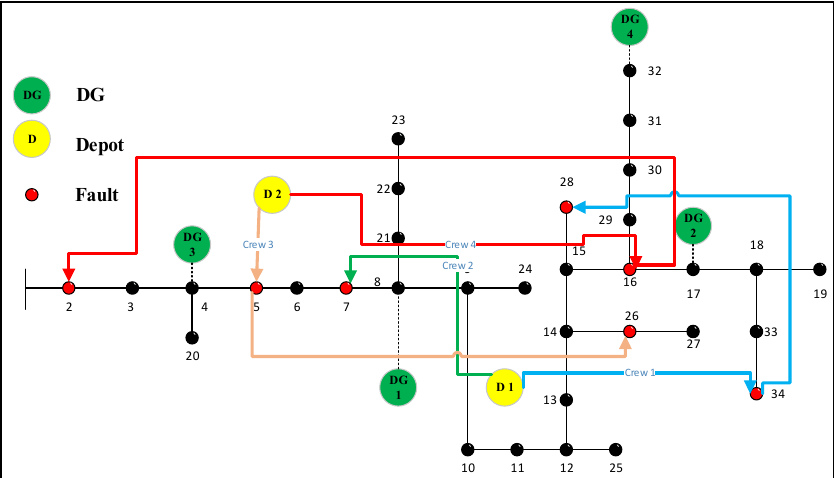
Figure 4. IEEE 34 bus Routing Repair Crew (RRC) schedule.